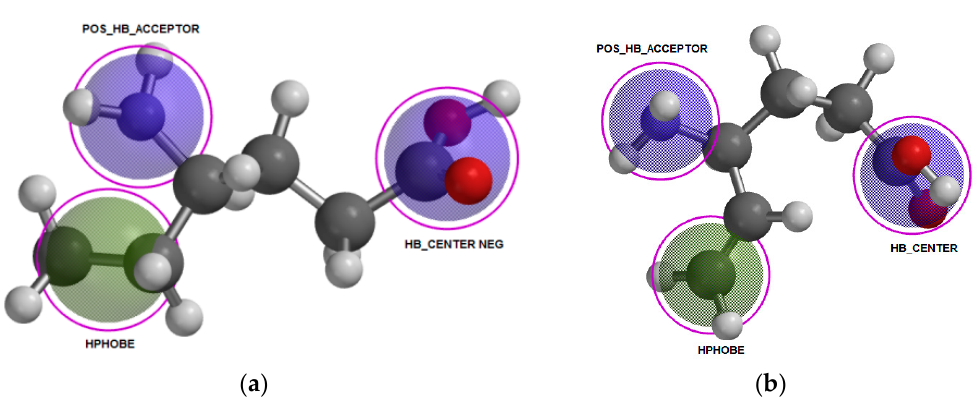
Figure 16. ( a ) Bioactive structure of VGB; ( b ) Minimum energy structure of VGB. The colored spheres are the CFD’s of VGB, where: HB_Center Neg is Hydrogen and Proton Negative Link Center, HPHOBE is Hydrophobic Region and POS_HB_Acceptor is Positive hydrogen bond acceptor center and basic region.